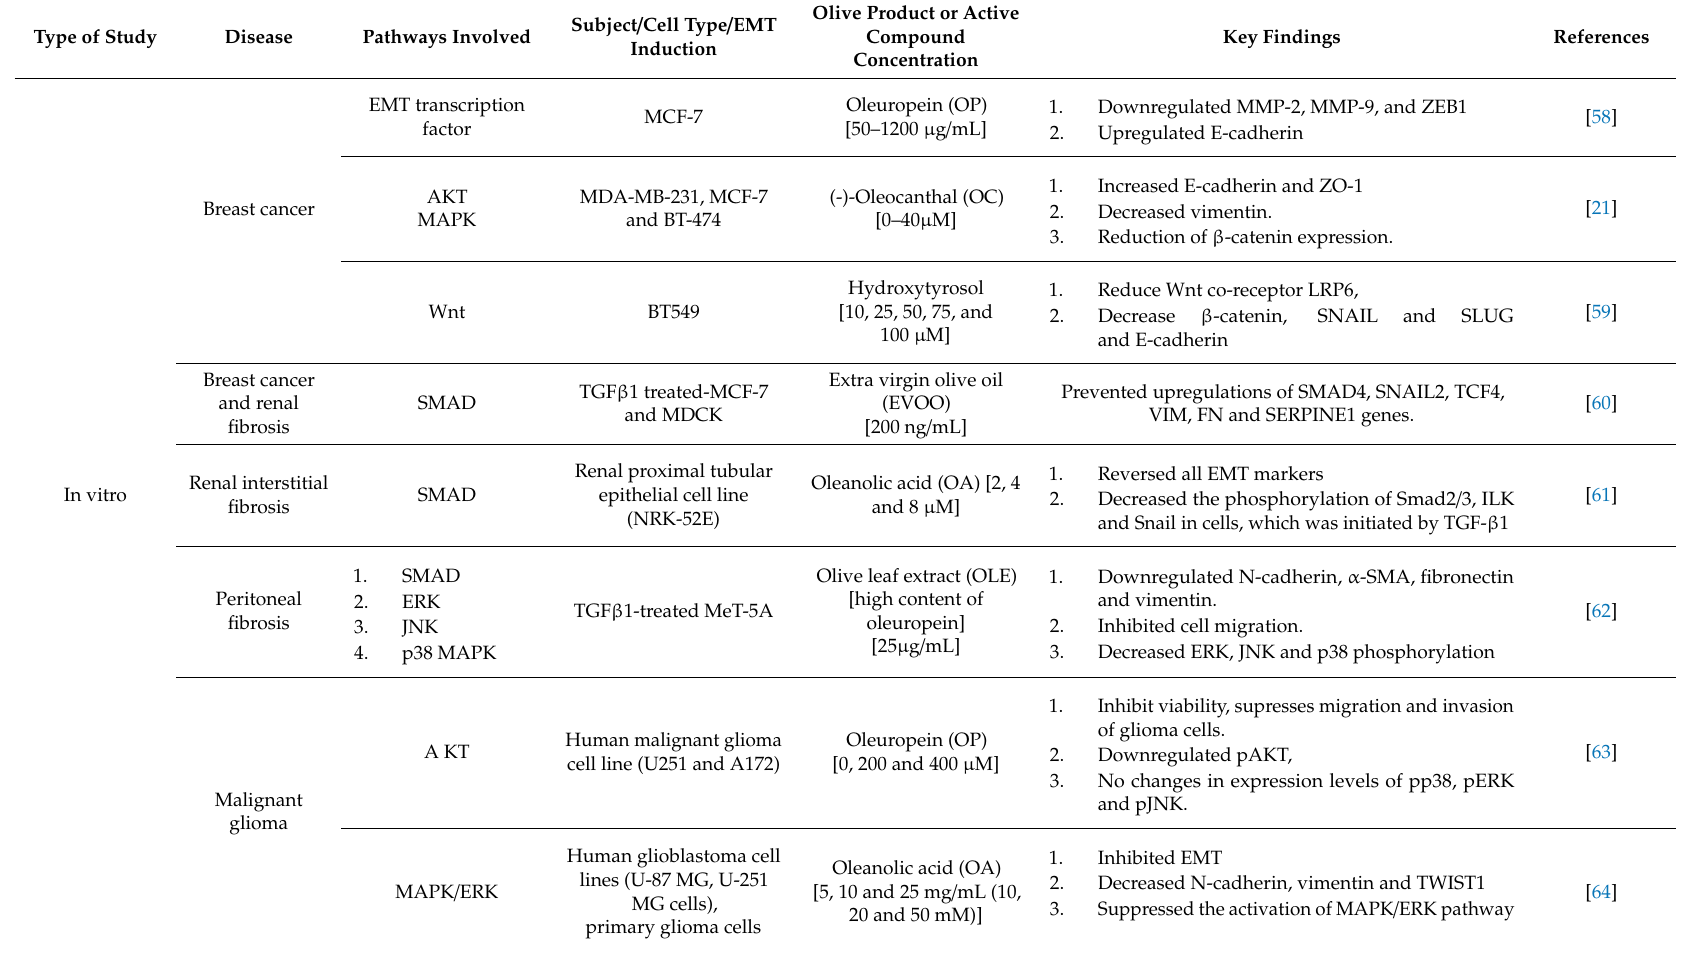
Table 1. Summary of olive and its active compounds and target signaling